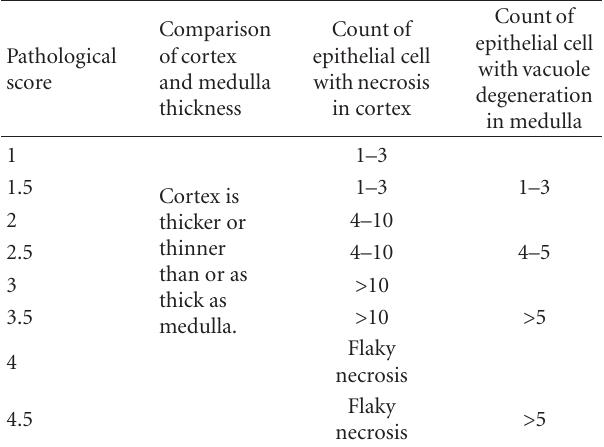
Table 1: Pathological score standard of